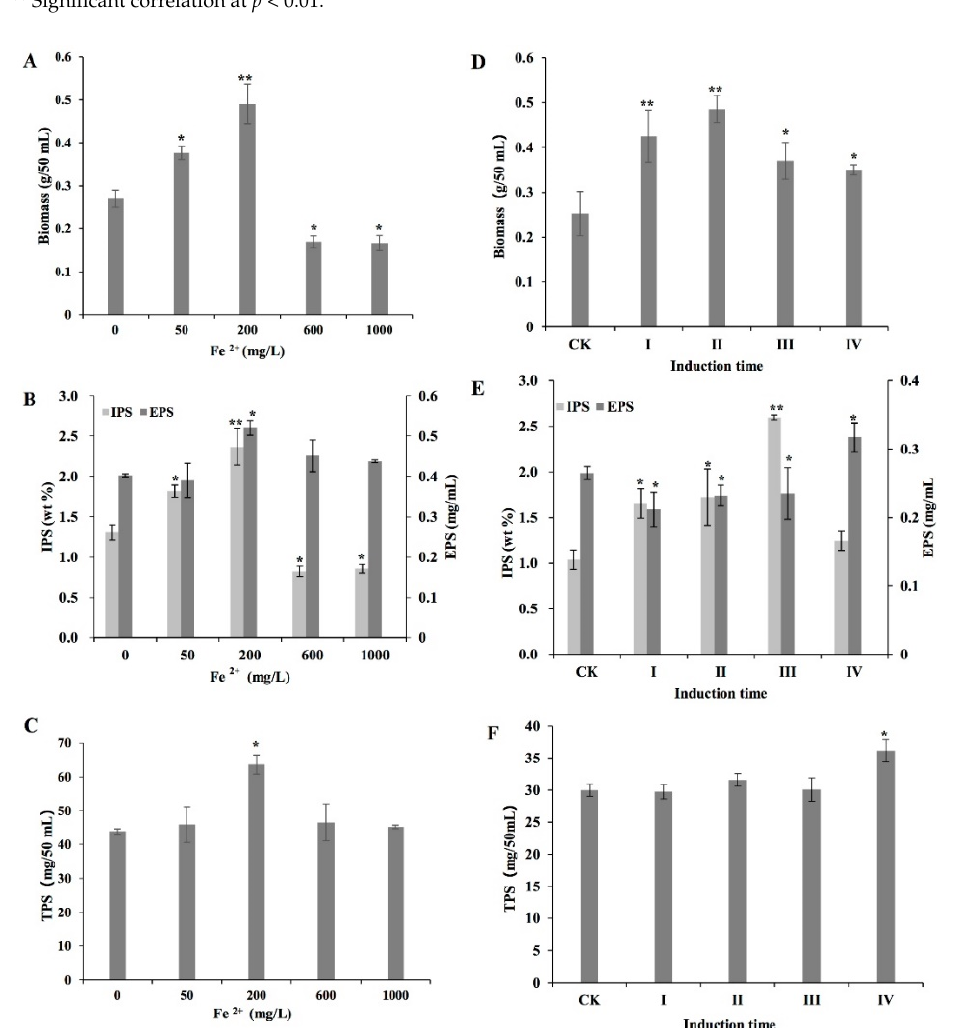
Figure 1. Effects of different Fe 2+ concentrations ( A – C ) and induction times ( D – F ) on biomass, extracellular polysaccharide (EPS), intracellular polysaccharide (IPS) and total polysaccharide (TPS) production by Lentinula edodes strain 808 (ACCC 52357). CK: control, cultures in a liquid medium without Fe 2+ . Fe 2+ was added as FeCl 2 : (I) at the time of inoculation; (II) after 3 days of static culture; (III) after 7 days of shaking at 150 rpm; and (IV) after 7 days of shaking at 150 rpm and 3 days of static culture. After the addition of Fe 2+ , the cultures were grown in static conditions. All cultures were incubated at 25 °C. Data were recorded after 50 days. Values are the means of experiments in triplicate ± SD. Asterisks indicate a significant statistical difference at p < 0.01 (**) and p < 0.05 (*), according to the least significant difference (LSD) test.